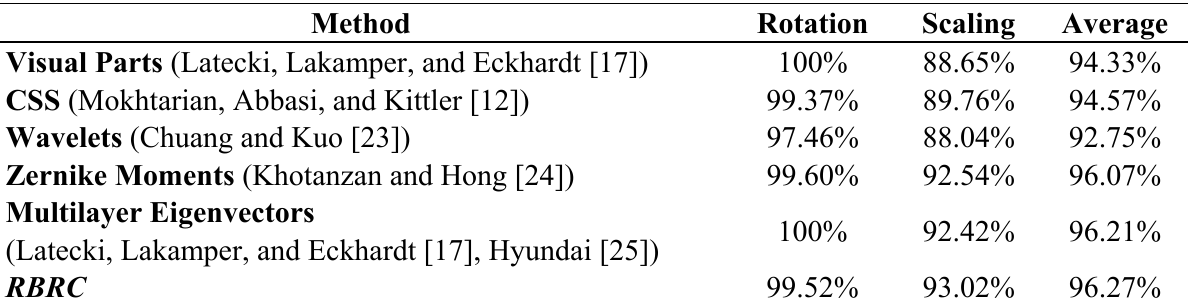
Table 4. Results for rotation and scale